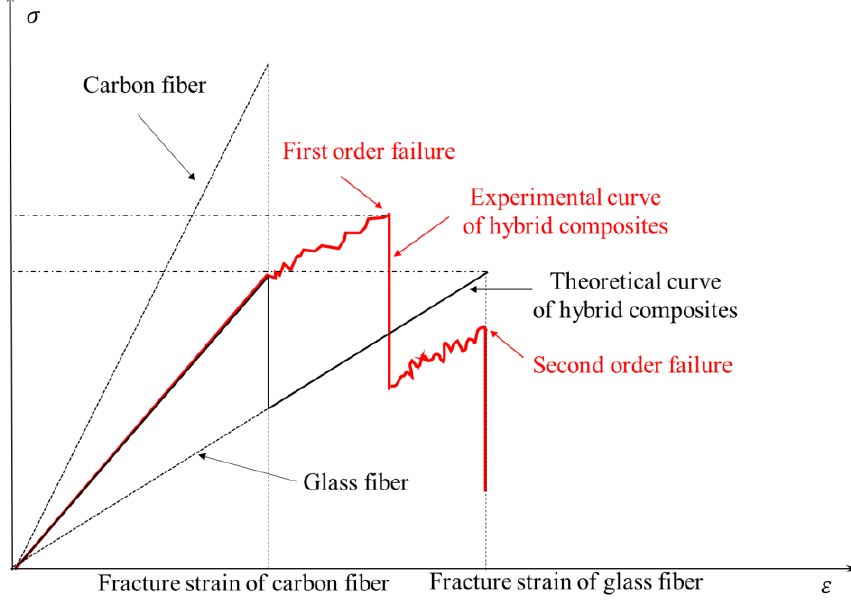
Figure 17. Tensile stress–strain curves of C/G hybrid composites.